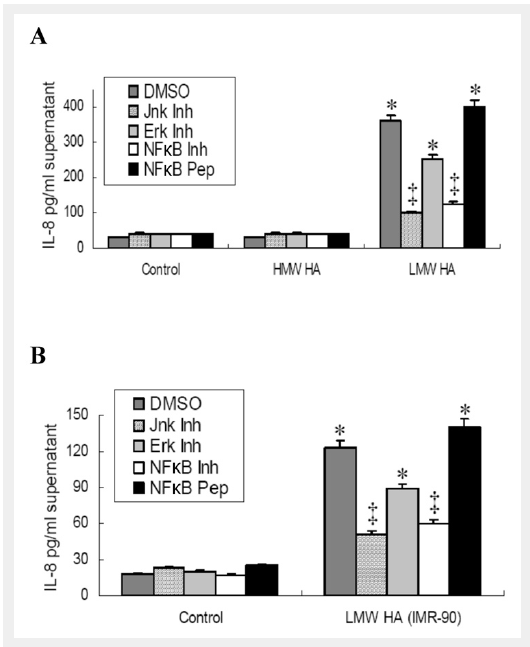
Figure 4 Inhibition of JNK and NF-κB, but not ERK, blocked LMW-HA induced IL-8 production in human BEAS-2B bronchial epithelial. BEAS-2B cells were pre-incubated with inhibitors of JNK, ERK, and NF-κB or with an NF-κB control peptide for one hour before HA stimulation. BEAS-2B cells were then exposed to LMW-HA, HMW HA, or no HA with carrier DMSO in serum free medium for 6 hours. A. LMW-HA from bovine vitreous humor and HMW HA from rooster comb (n = 5); B. LMW-HA isolated from IMR-90 fibroblast HA (n = 3). * p <0.05 vs controls; HMW HA; LMW-HA+JNK inhibitor and LMW- HA+NF-κB inhibitor. ‡ p <0.05 vs. LMW-HA+DMSO; LMW-HA+ERK inhibitor and LMW+NF-κB control